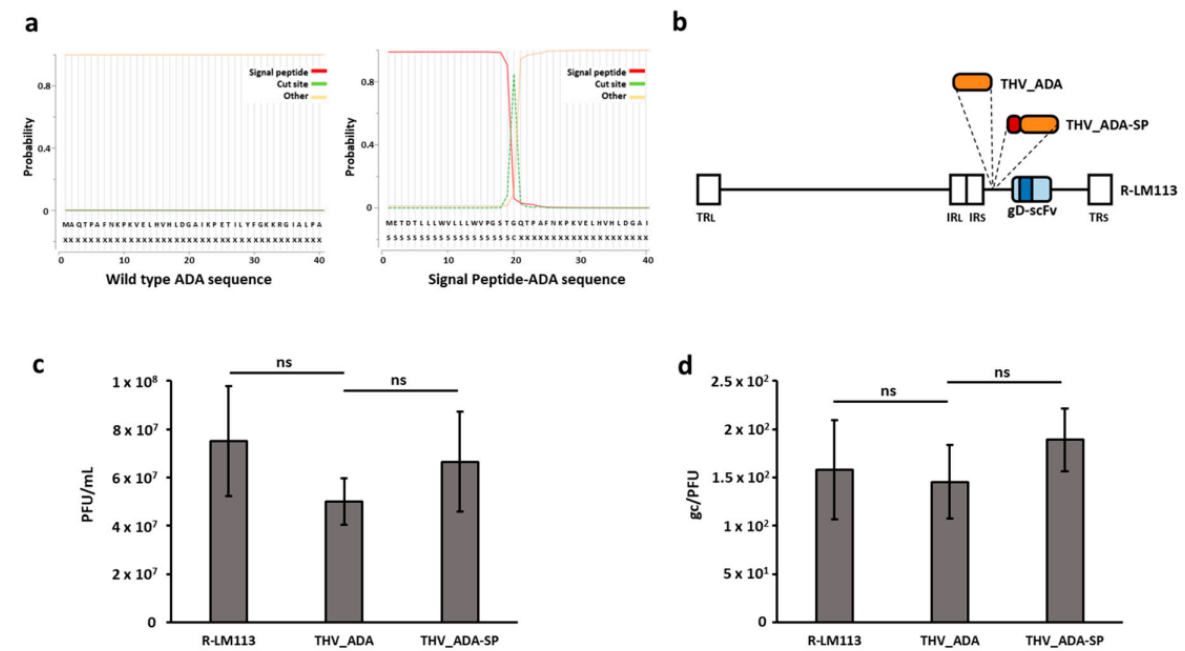
Figure 2. Generation of Adenosine Deaminase-armed targeted herpes viruses. ( a ) 40 N terminus aa of wild-type and SP-bearing murine ADA were analyzed by SignalP 5.0 server to evaluate the presence and proficiency of the signal peptide. Non-signal peptide (Other, yellow line) and Signal Peptide (SP, red line) moieties are reported as 0 (0%) to 1 (100%) probability. The cut site of SP (CS) is indicated as dashed green line. ( b ) Schematic representation of THVs expressing ADA and ADA-SP. The scFv targeting hHER2 (dark blue) is shown in glycoprotein D (light blue). ( c ) The yield of R-LM113, THV_ADA, and THV_ADA-SP oncolytic viruses was evaluated in SKOV3 cells infected at MOI of 0.1 pfu/cell. Yield was reported as pfu/mL obtained by plaque assay from two biological replicates of infection. ( d ) Virion infectivity was measured as gc/PFU ratio. Non-statistically significant differences were reported as Not Significant